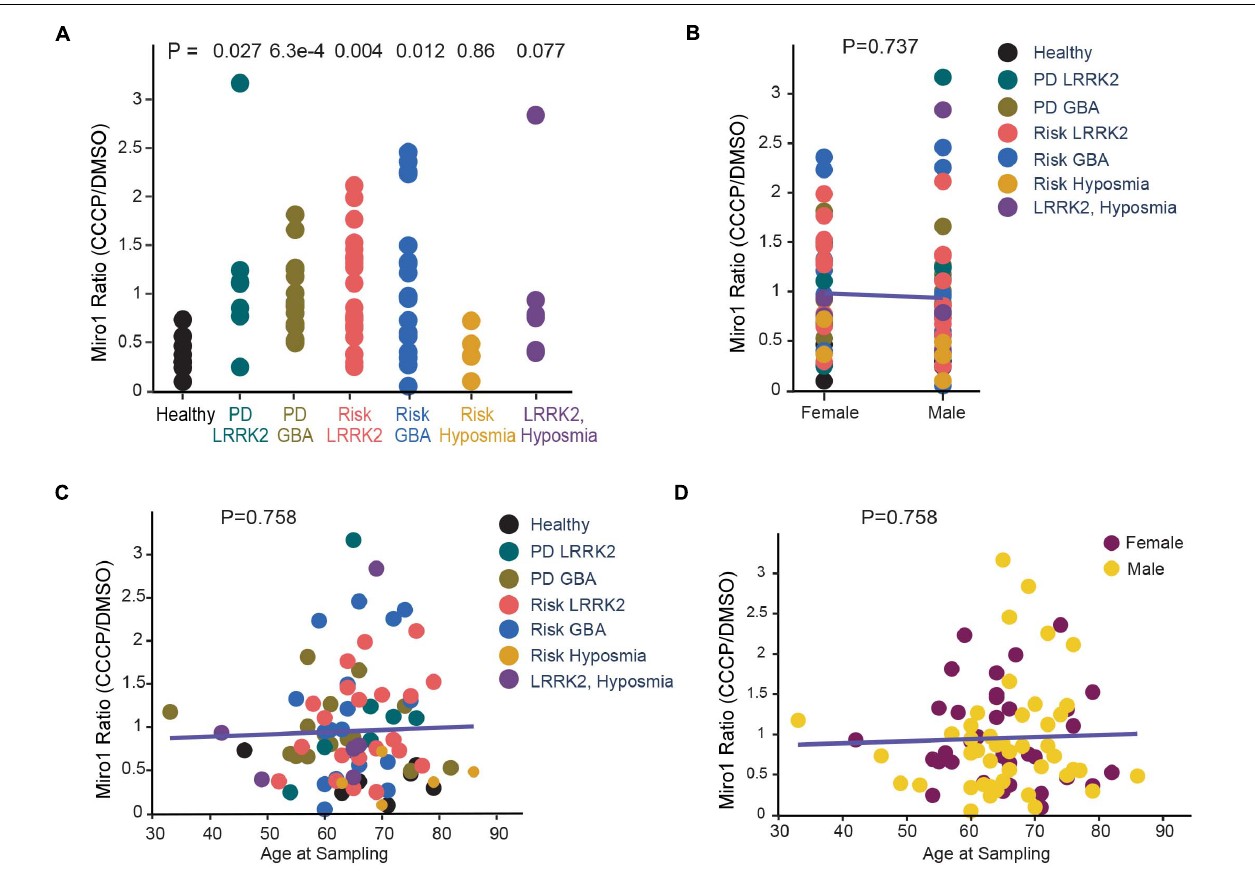
FIGURE 2 | Correlation Analysis of Miro1 Ratio in iPSCs. (A) One-Way Anova is used to determine the significant difference among all groups. (B) Two-Way Anova is used to determine the interaction between sex and genetic background with Miro1 ratio as the response variable. (C, D) Multivariable regression is used to determine the interaction between age and genetic background (C) , or age and sex (D) , with Miro1 ratio as the response variable. All P values are calculated by linear